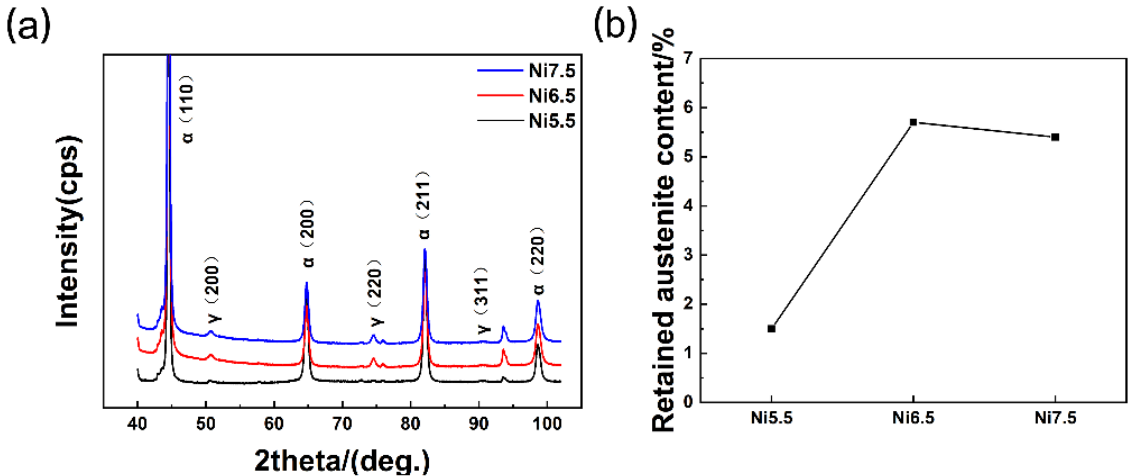
Figure 10. ( a ) The result of XRD analysis of the deposited metals. ( b ) The content of RA in the deposited metals.